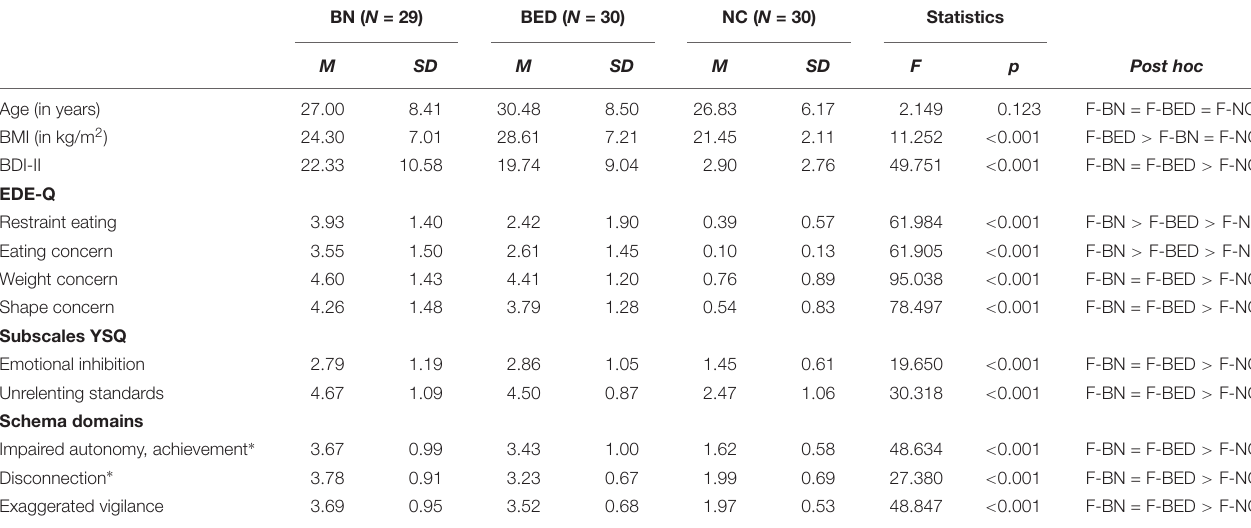
TABLE 3 | Means and standard deviations of sample characteristics and relevant early maladaptive schema (EMS) and schema domains. BN ( N = 29) BED ( N = 30)